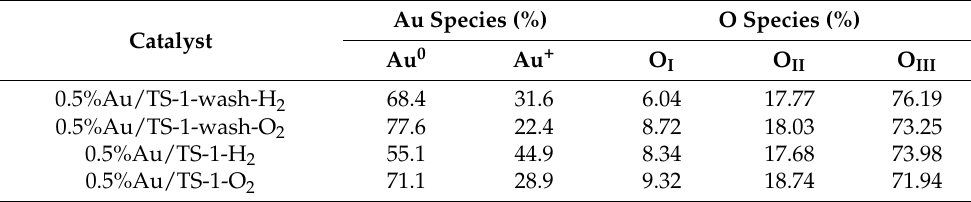
Figure 6. XPS spectra of the Au/TS-1 catalysts: ( a ) Au 4f, ( b ) Ti 2p and ( c ) O 1s. Table 2. Quantitative analysis of Au and O species on the catalyst based on XPS